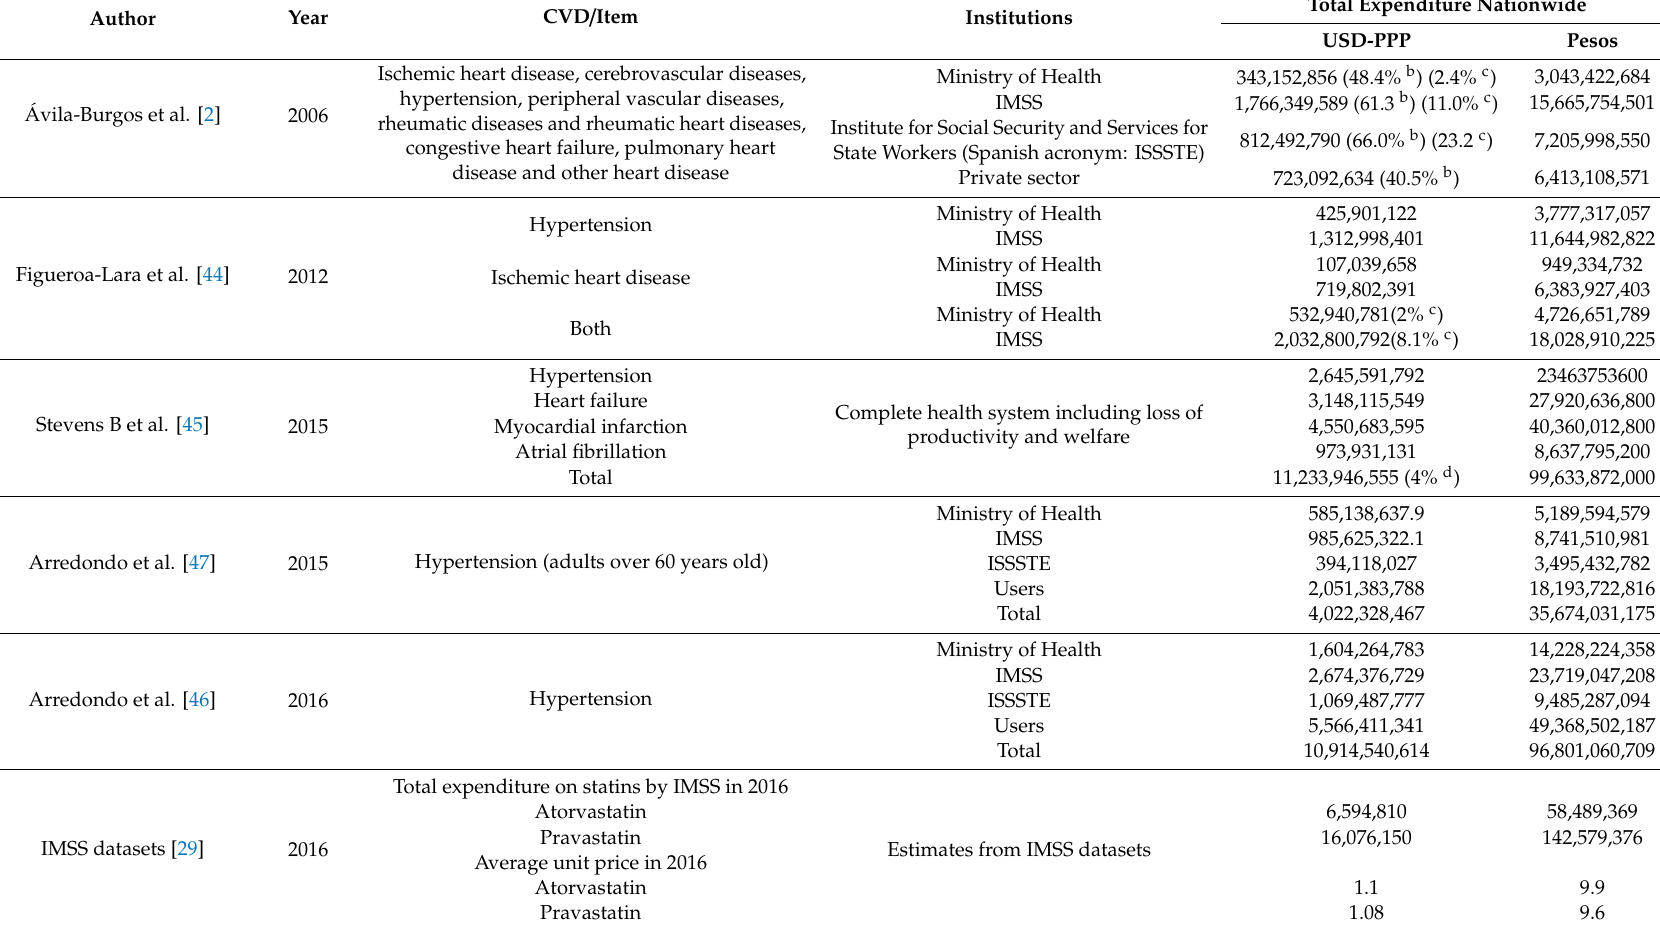
Table 5. Estimated expenditures for CVD in Mexico expressed in USD-PPP and pesos a ,